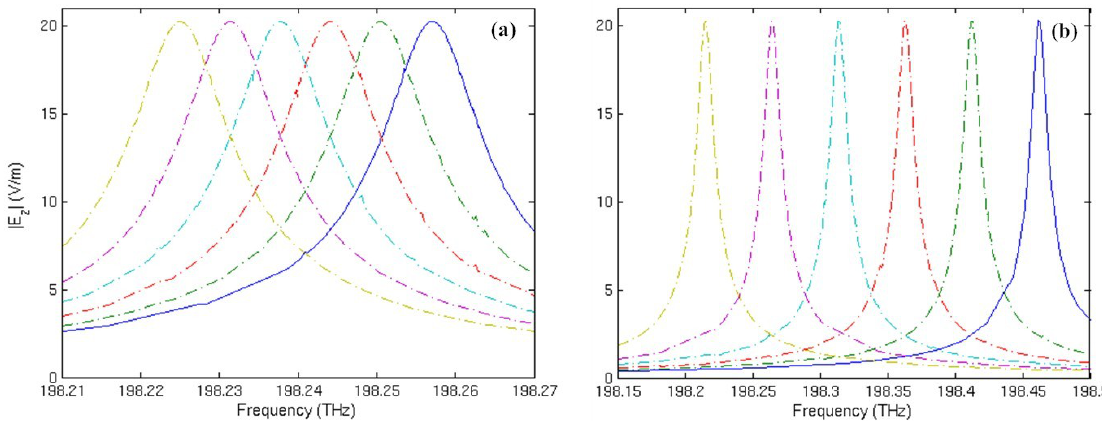
Figure 7. Resonant frequency spectrum of mode 27 with respect to the change of adsorbed substance permittivity ε . From left to right, the curves correspond to s 1.08 and 1.1, respectively. (a) The traditional microring sensor. (b) The metamaterial